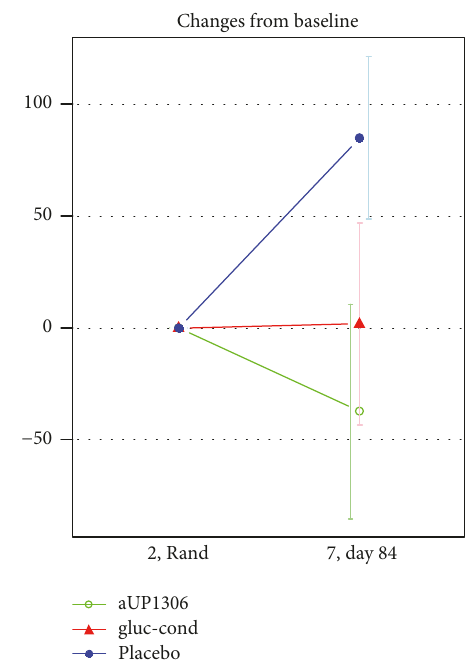
Figure 2: Changes in CTX-II from baseline to 12 weeks. (i) 𝑥 -axis = time-points; 𝑦 -axis = change in CTX-II